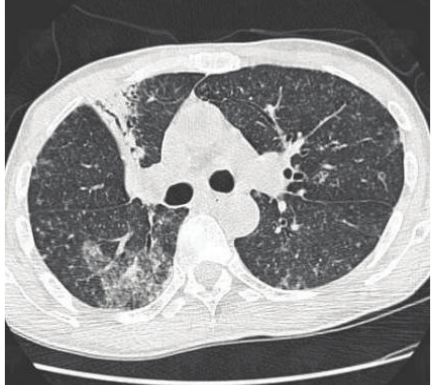
Figure 2: Alveolar-interstitial opacities at the left lower lobe.